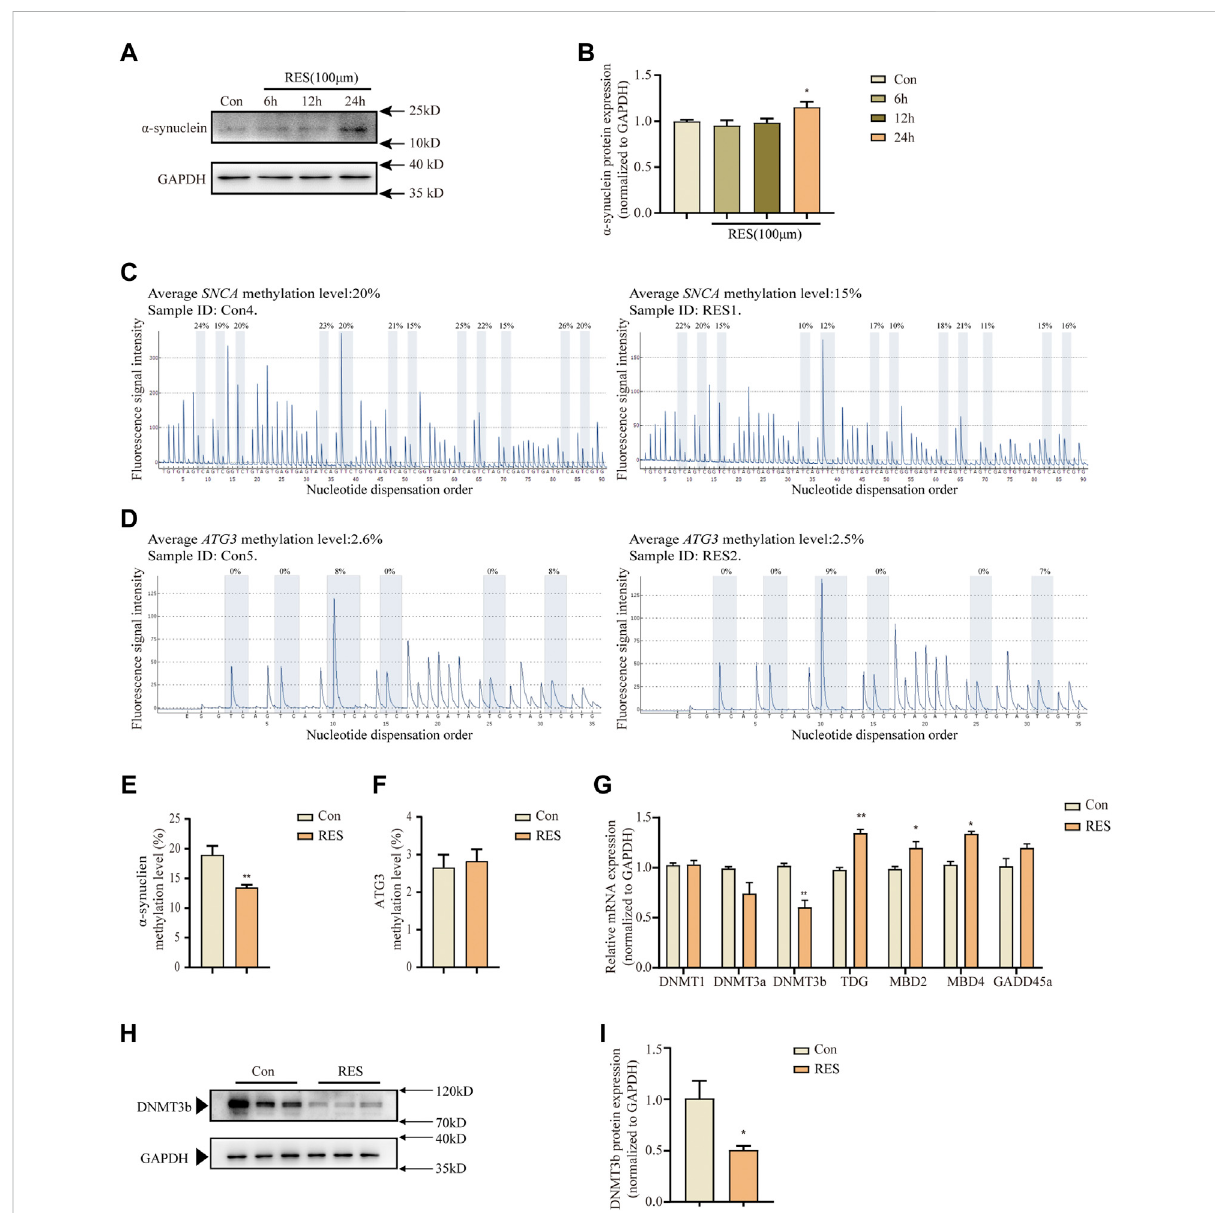
FIGURE 3 Reserpine treatment in SH – SY5Y cells induced decreased DNA methylation levels. (A,B) Reserpine treatment resulted in elevated protein expression of SNCA in SH – SY5Y cells (n = 3 for each group, one-way ANOVA with Dunnett post hoc test, * p < 0.05 vs. control). (C,E) Reserpine treatment decreased DNA methylation of SNCA for a subset of CpG by pyrosequencing analysis. (C,E) are representative samples and statistical analysis,respectively( n =6foreachgroup,studentt-test,** p < 0.01vs.control). (D,F) ReserpinetreatmentdidnotchangetheDNAmethylation levels of ATG3 . (D,F) are representative samples and statistical analysis, respectively (G) Differential expression analysis for methylation-related enzymes by qRT-PCR ( n = 5 for each group, student t-test, * p < 0.05, ** p < 0.01 vs. control). (H,I) Reserpine treatment resulted in decreased protein expression of DNMT3b in SH-SY5Y cells ( n = 3 for each group, student t-test, * * p < 0.05 vs. control). All data are expressed as mean ± SEM; Con, control; RES,